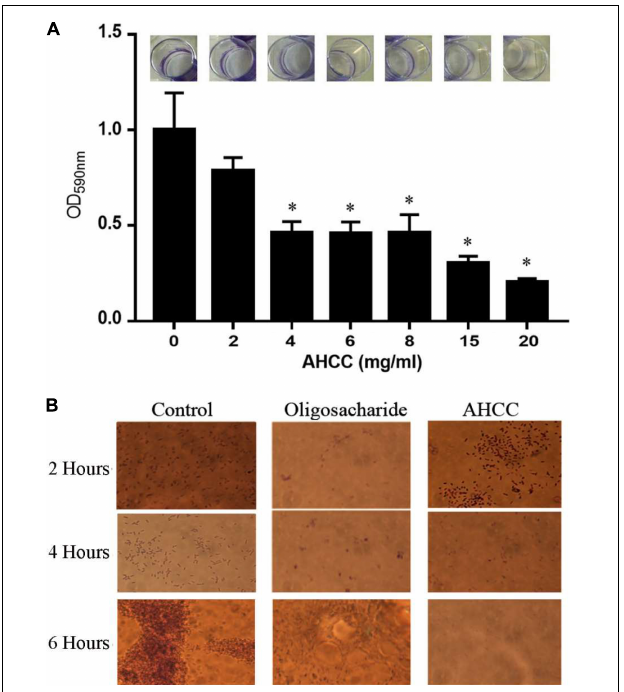
FIGURE 2 | Formation of P. aeruginosa biofilm. (A) Biofilm formation in the absence and in the presence of different concentrations of AHCC R (cid:13) in 24-well plates. Biofilm formation was monitored in M9 minimal medium supplemented with 0.2% (w/v) glucose and casamino acids and quantified after 6 h. Then, the relative amount of biofilm formation in the experiments was represented against AHCC R (cid:13) concentration. Data are the average of three independent assays. (B) Microscopic inspection of biofilm formation in the absence and in the presence of 10 mg/mL of AHCC R (cid:13) at 2, 4 and 6 h.